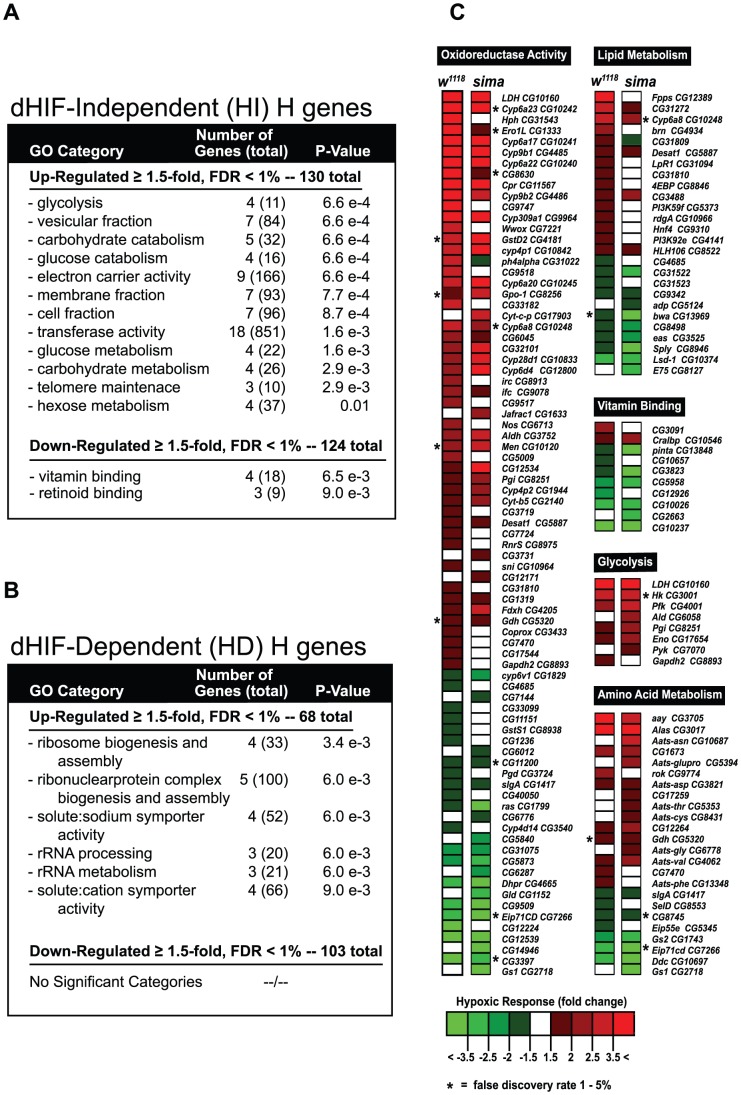
HIF-dependent and HIF-independent hypoxic response genes.(A–B) Gene ontology (GO) analysis was performed on HIF-independent (HI) and HIF-dependent (HD) gene sets that were derived from microarray analysis of H- or N-treated control (w1118) animals or sima mutants collected at the partial clear-gut late-L3 time. See Figure S1 for the analysis scheme. GO categories are listed in order of statistical significance. The numbers of H-regulated genes affected are shown along with the total number of genes in each category. All transcripts are up- or downregulated at least 1.5-fold and have a false discovery rate (FDR) of <1%. (C) A heat map was created to illustrate the similarity or dissimilarity of hypoxic responses for major GO categories impacted by H-treatment in control animals and sima mutants. Red (upregulated), green (downregulated), or white (no significant change) values represent hypoxic responses observed in the backgrounds indicated. For this analysis, FDR stringency was <1%, unless otherwise noted with * for a particular genotype, where a relaxed gate was used (1–5%).